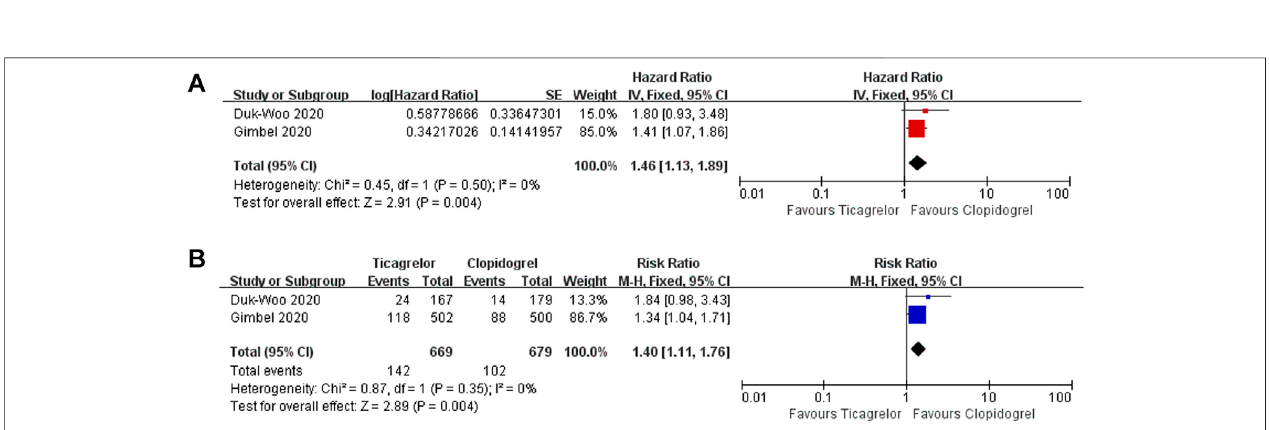
FIGURE5| Meta-analysis withHR (A), RR (B) ,and 95%CI forthePLATO major bleeding or minor bleeding. Boxes arethe relative riskestimates from each study; the horizontal bars are 95% CI. The size of the box is proportional to the weight of the study in the meta-analysis. HR, hazard ratio; RR, risk ratio; CI, con fi dence interval.